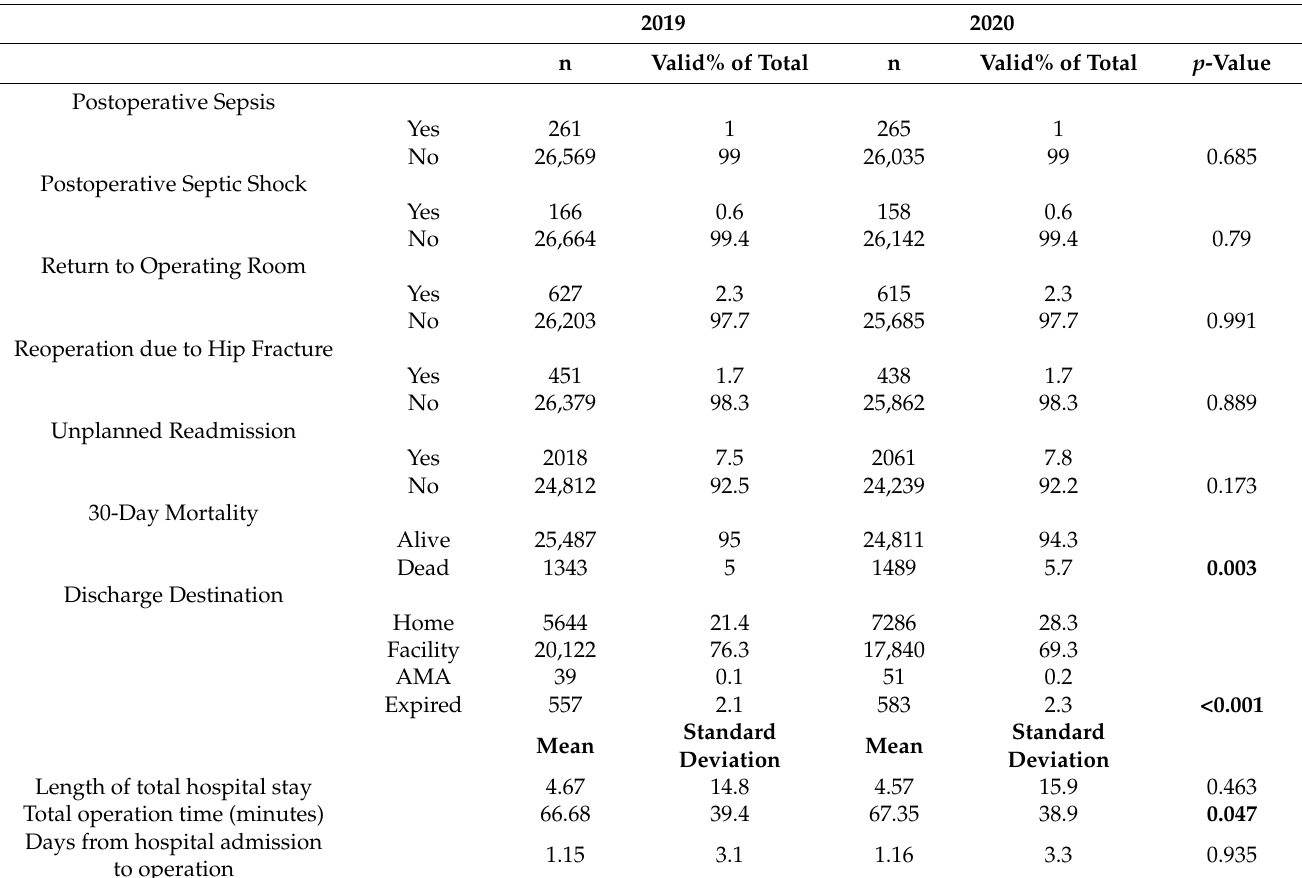
Table 2. Cont . Cross Table Year of Diagnosis and Postoperative Patient Characteristics with Traumatic Proximal Femoral